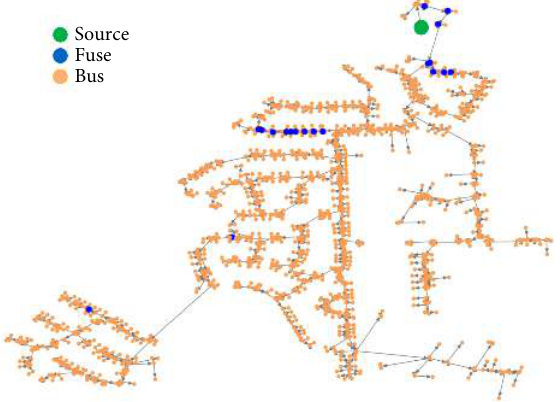
Fig. 6 Example configuration of one synthetic Austin distribution feeders.